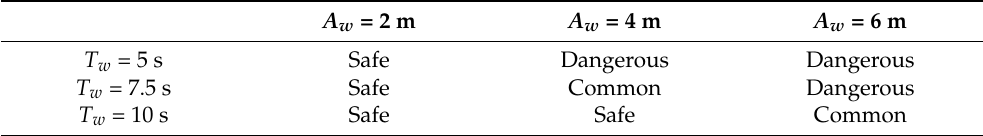
Table 4. List of the relative speeds at contact moment.